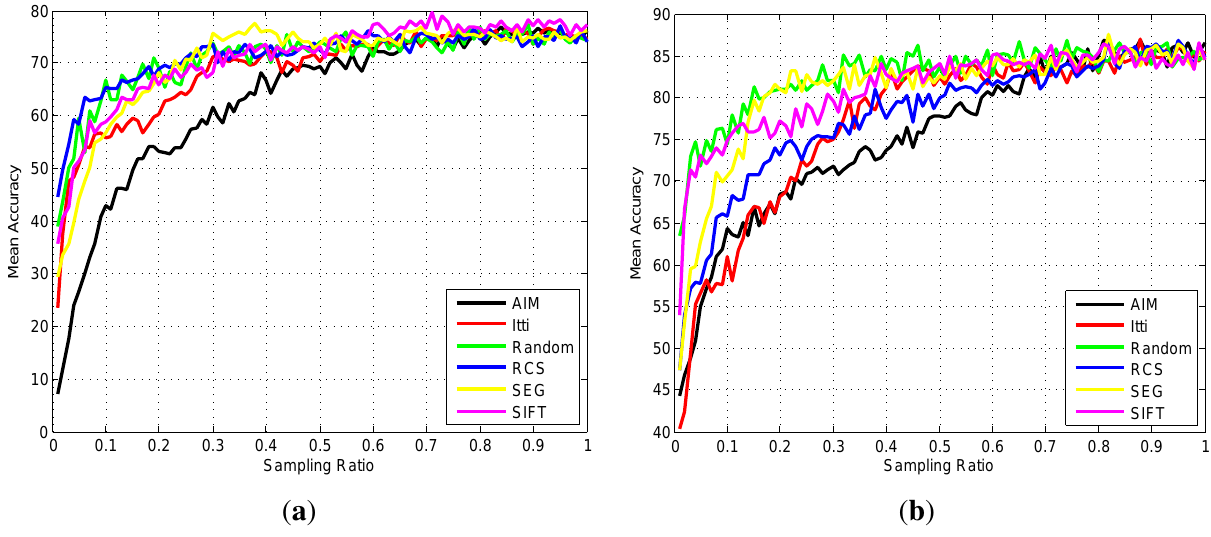
Figure 16. The classification accuracy using different sampling methods on buildings ( a ) and residential ( b